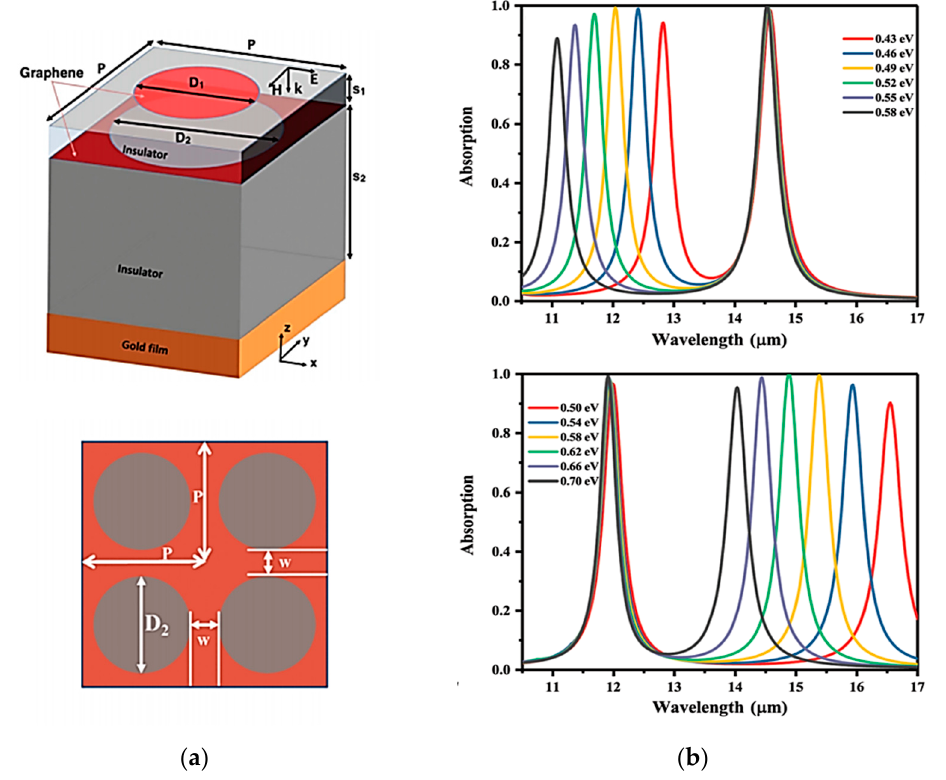
Figure 24. Dual-band independent tunable absorber ( a ) structure, and ( b ) absorption curves of graphene nanodiscs and graphene layers at different Fermi energy levels [62].